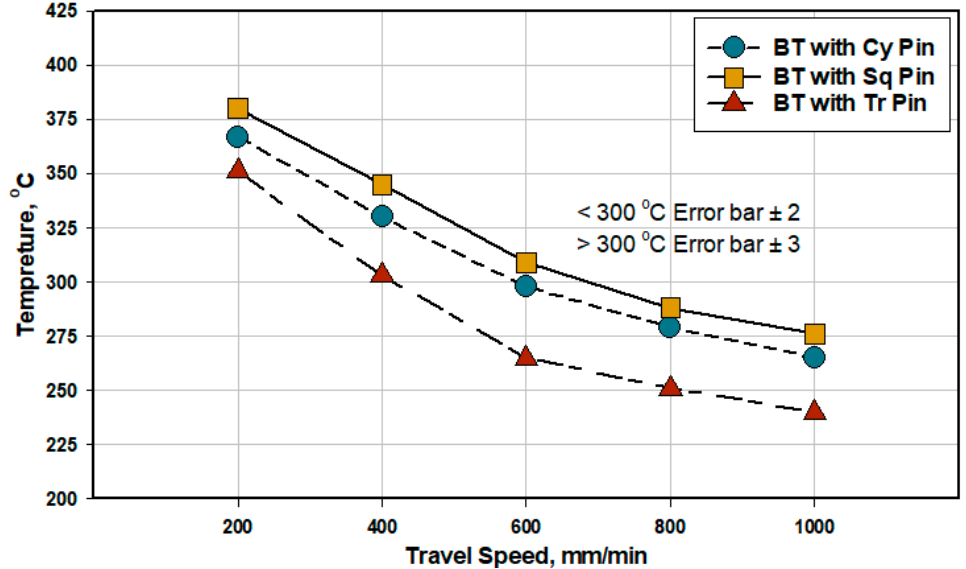
Figure 6. Effects of BT pin geometries and BT travel speed on the welding temperature in the stir zone to produce 10 mm AA1050-H14 similar lap joints. zone to produce 10 mm AA1050-H14 similar lap